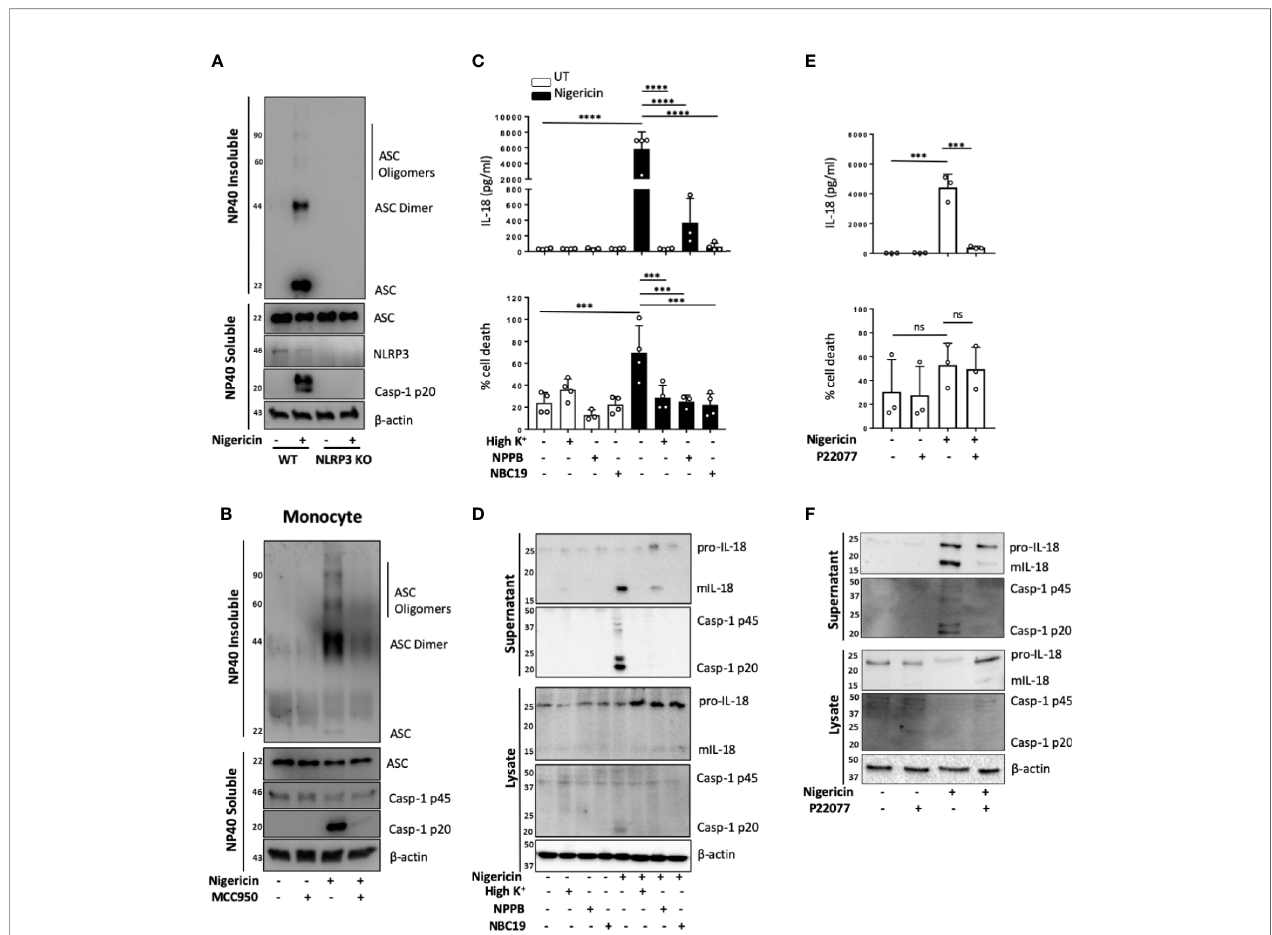
FIGURE 4 | Unprimed NLRP3 in fl ammasome activation has the same requirements as the canonical in fl ammasome. (A) WT and NLRP3 KO THP-1 cells were left unprimed prior to treatment with nigericin (10 µM, 2 h) to activate NLRP3 in fl ammasome. (B) Primary human monocytes were pre-incubated with MCC950 (1 µM) for 15 min prior to treatment with nigericin (10 µM, 45 min). The NP-40 soluble fraction and DSS crosslinked insoluble fraction were immunoblotted for ASC monomers, dimers and oligomers. Blots are representative of 3 independent biological experiments and blood donors. (C, D) THP-1 cells were left unprimed and pre-incubated with high K + buffer, NPPB (50 µM) or NBC19 (25 µM) for 15 min prior to treatment with nigericin (10 µM, 45 min). (E, F) THP-1 cells were left unprimed pre- incubated with P22077 (2.5 µM, 15 min) prior to treatment with nigericin (10 µM, 45 min). n=3 independent biological replicates, mean ±; S.D., ***P < 0.001; ****P < 0.0001; ns (not signi fi cant) using one-way ANOVA comparing each sample to nigericin only treated sample. (D, F) Supernatants and lysates were analyzed for mIL- 18 (18 kDa), pro-IL-18 (24 kDa), mCaspase-1 (20 kDa), pro-Caspase-1 (45 kDa), as well as loading control b -actin (42 kDa). Blots are representative of at least 3 independent experiments and in the case of primary monocytes, blood